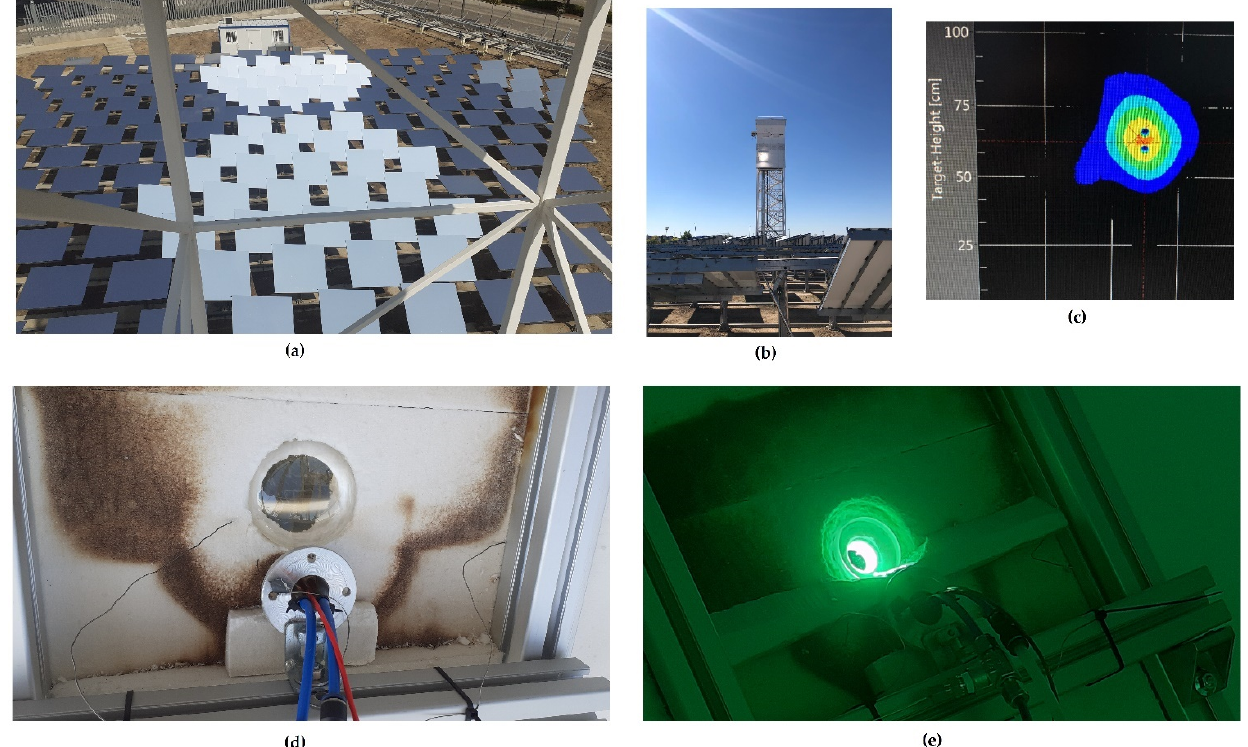
Figure 8. Details of experimental setup of the irradiation tests using the Very High Concentration Solar Tower (VHCST). ( a ) Heliostat field; ( b ) central tower; ( c ) image provided by infrared camera software, showing the temperature distribution on the target (made of alumina foam) at the top of the tower; ( d ) photo showing the test setup used for a lens (with 76.2 mm diameter) simply surrounded by alumina foam and aspect of the Gardon-type radiometer; ( e ) photo taken during an irradiation test on a lens (with 50.8 mm diameter) simply surrounded by alumina foam and aspect of the Gardon-type radiometer below the lens.